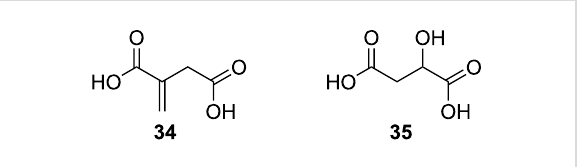
Figure 11: Iataconic ( 34 ) and malic ( 35 ) acid.